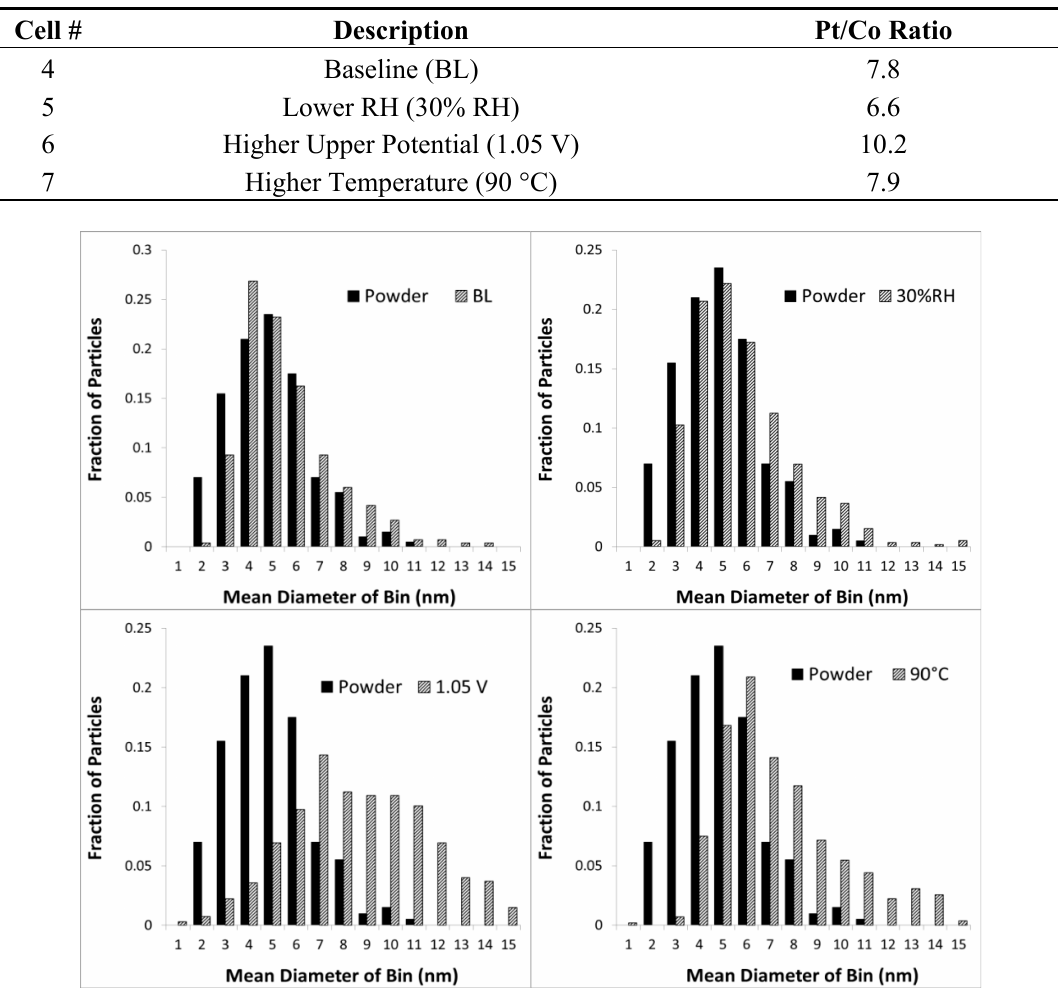
Table 5. The post-cycling Pt to Co ratios in the electrodes of the cells subjected to the parametric study square wave decay protocol.